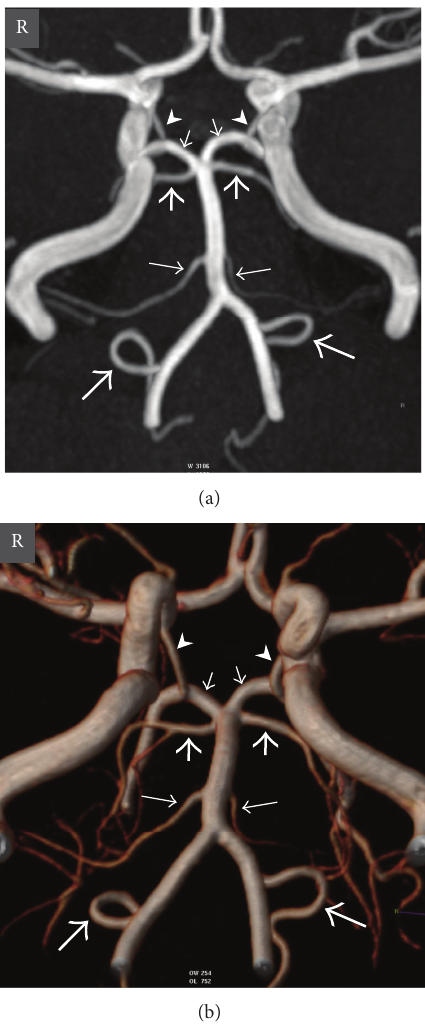
Figure 1: Oblique coronal view maximum intensity projection (MIP) (a) and volume-rendered (VR) (b) time-of-flight (TOF) mag- netic resonance (MR) angiography images show normal anatomy of the vertebrobasilar circulation in a 20-year-old woman. Thick long arrows = right and left posterior inferior cerebellar arteries (PICAs), thin long arrows = right and left anterior inferior cerebellar arteries (AICAs), thick short arrows = right and left superior cerebellar arteries(SCAs), thin short arrows =right and leftposterior cerebral arteries (PCAs), arrowheads = right and left posterior communicating arteries (PCoAs), and R =